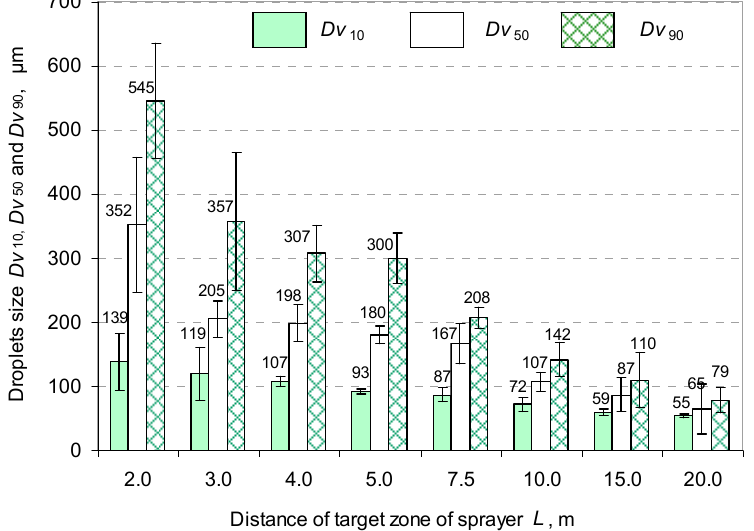
Figure 9. Droplet size parameters Dv 10 , Dv 50 , and Dv 90 as a function from distance of target zone of sprayer L when spraying DRA7e with a sprayer with five air-injector flat spray nozzles (lateral wind velocity v = 10 m s − 1 ).